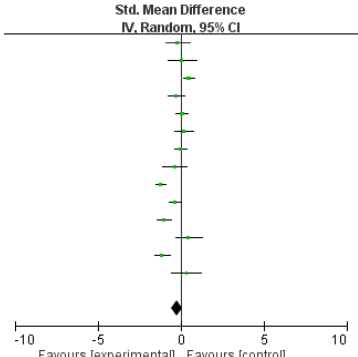
Figure 3. Effect of mindful exercise on anxiety symptoms in comparison to non-mindful exercise. Table 3. Effect of yoga on anxiety symptoms in comparison to non-mindful exercise. Yoga Non Mindful Exercise Std. Mean Di ff erence Study or